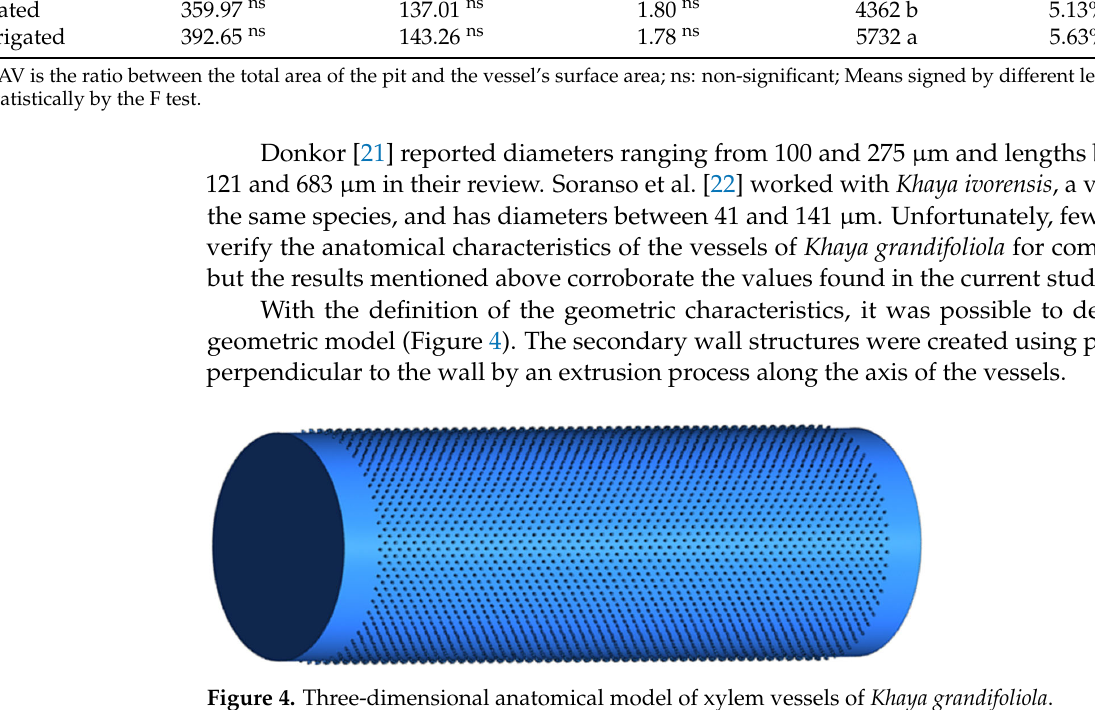
Table 1. The mean geometric pattern of xylem vessels in the stems of irrigated and non ‐ irrigated Khaya grandifoliola plants. Treatment Length ( µ m)